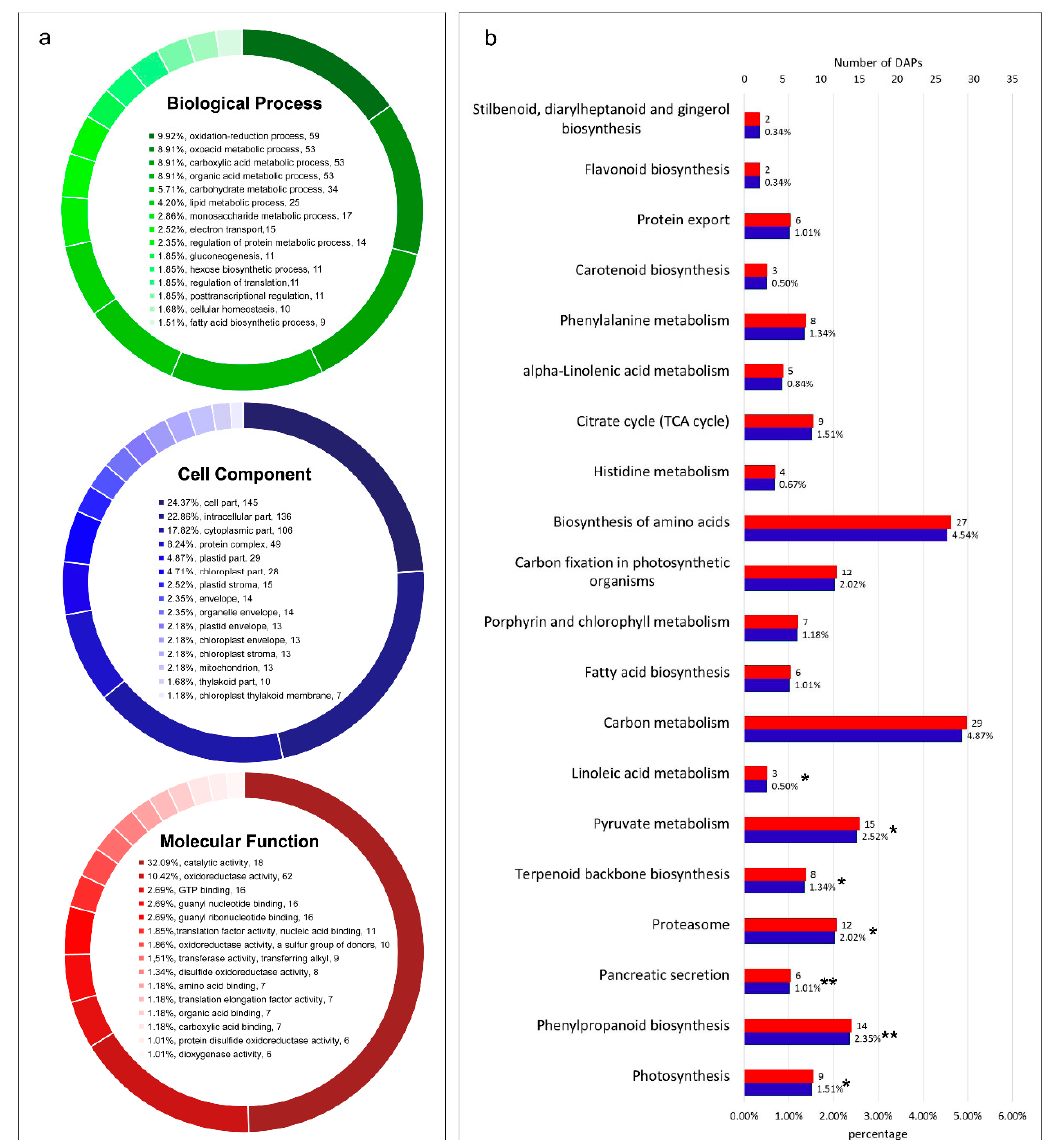
Figure 3. Gene Ontology (GO) function classification and Kyoto Encyclopedia of Genes and Genome (KEGG) pathway enrichment analysis of DAPs. ( a ) GO function classification of DAPs. The three pie charts showed the functional annotation of DAPs in three root categories (“biological process”, “cellular component”, and “molecular function”) of the GO database, respectively. ( b ) KEGG pathway enrichment analysis of DAPs. Top 20 pathways with the smallest p -value are demonstrated. Asterisks indicate the significance of enriched pathways (** p < 0.01, * p < 0.05).